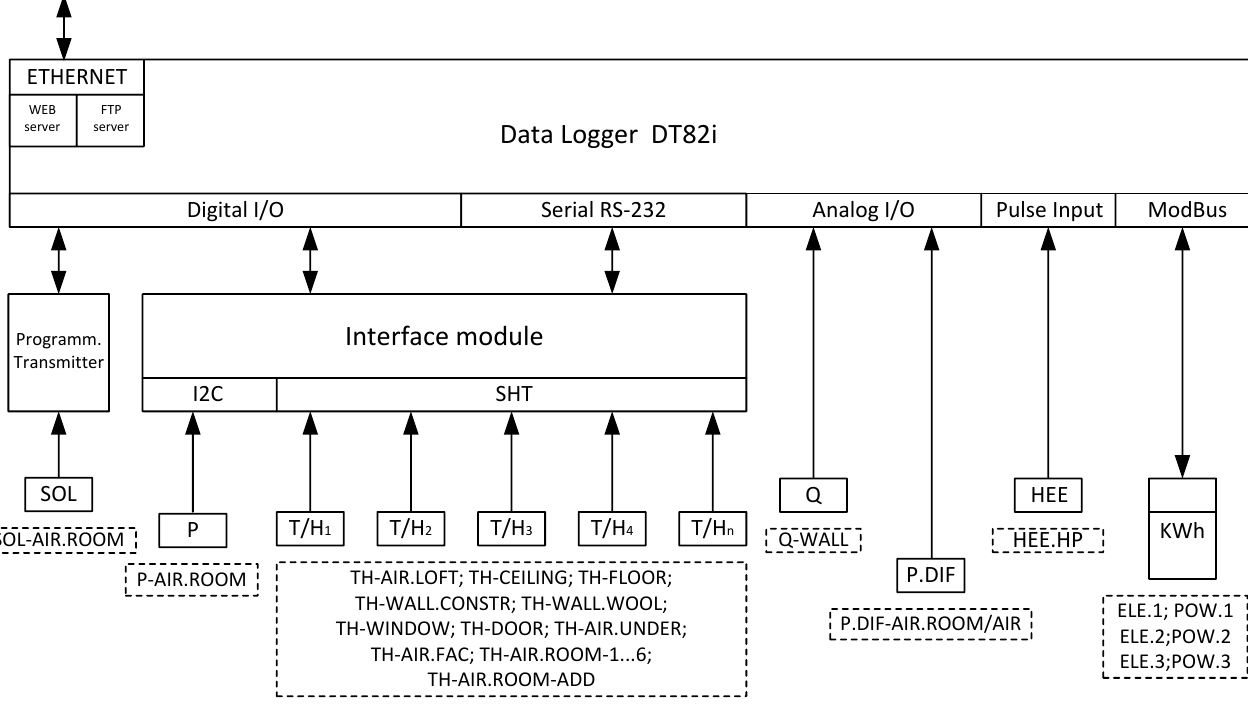
Fig. 4. WDAS structure of a test